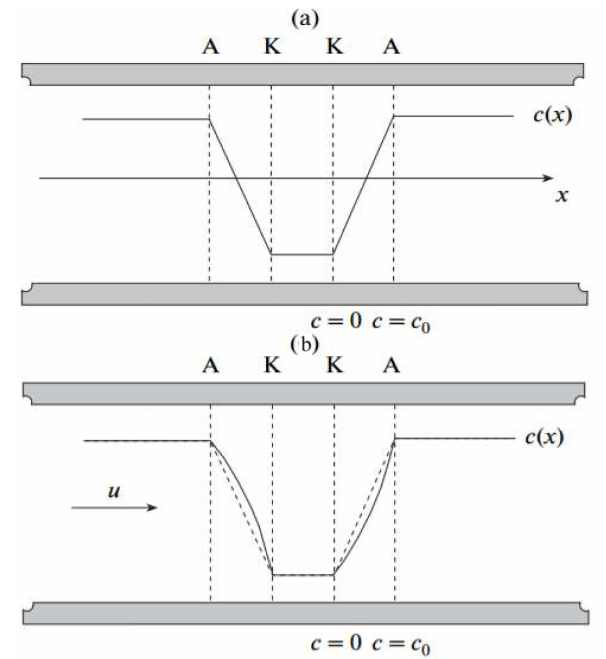
Figure 2. Distribution of the electrolyte concentration in the elec- trode assembly with mesh permeable electrodes. c ( x ) is the steady- state concentration of triiodide ions; (a) concentration distribution without mechanical motion; (b) shows how the distribution of con- centration c ( x ) varies under the influence of the oncoming flow of liquid; u – fluid flow rate. A – anodes, K – cathodes.